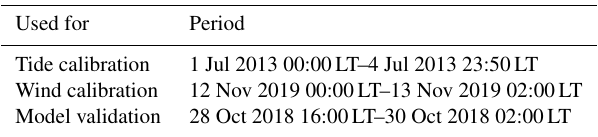
Table 6. Considered conditions for calibration and validation. Used for